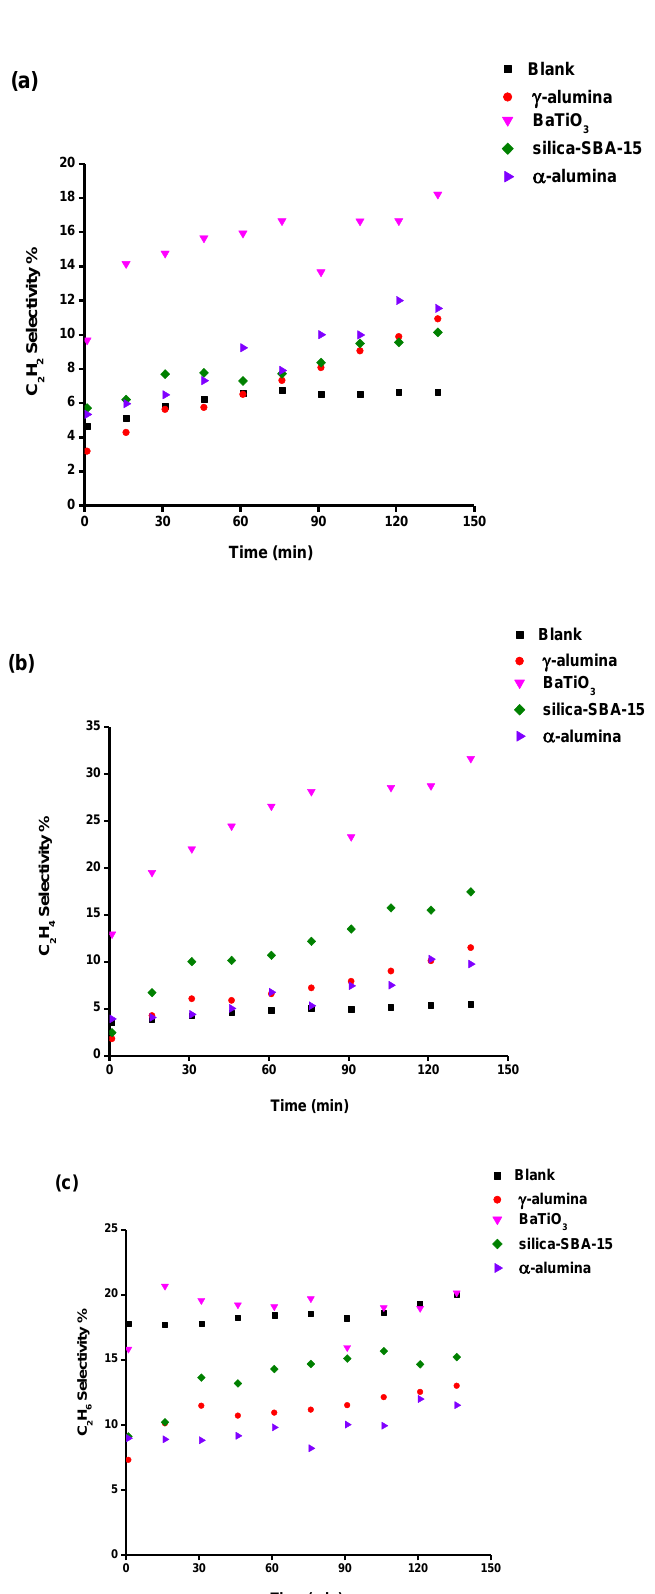
Figure 5. Selectivity of C 2 products as a function of time for different packing materials: ( a ) Acetylene selectivity; ( b ) ethylene selectivity; and ( c ) ethane selectivity.